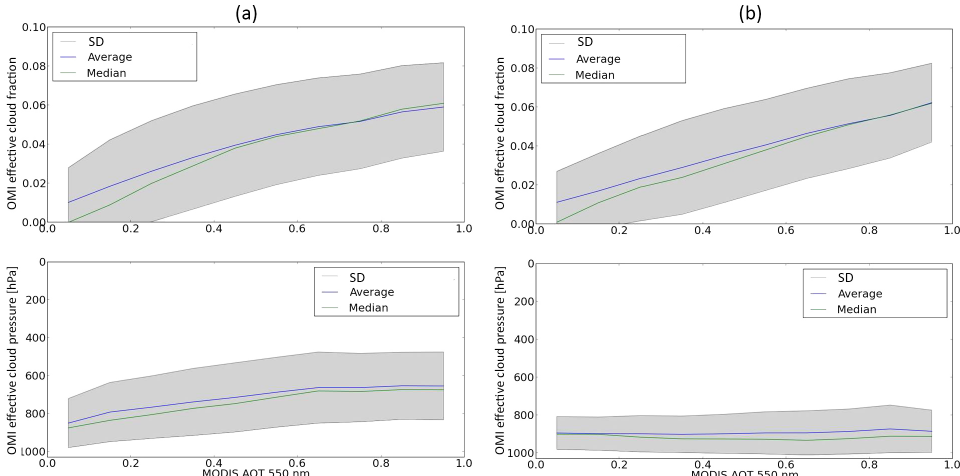
Figure 7. Effective cloud fraction and cloud pressure extracted from OMI DOMINO v2 compared to MODIS Aqua AOT for 2 seasons. Statistics are computed over 3years (2005, 2006, 2007) and following the methodology described in Sect. 3.1: (a) summer (June, July, August), (b) winter (December, January, February) over East China. SD here is the standard deviation.